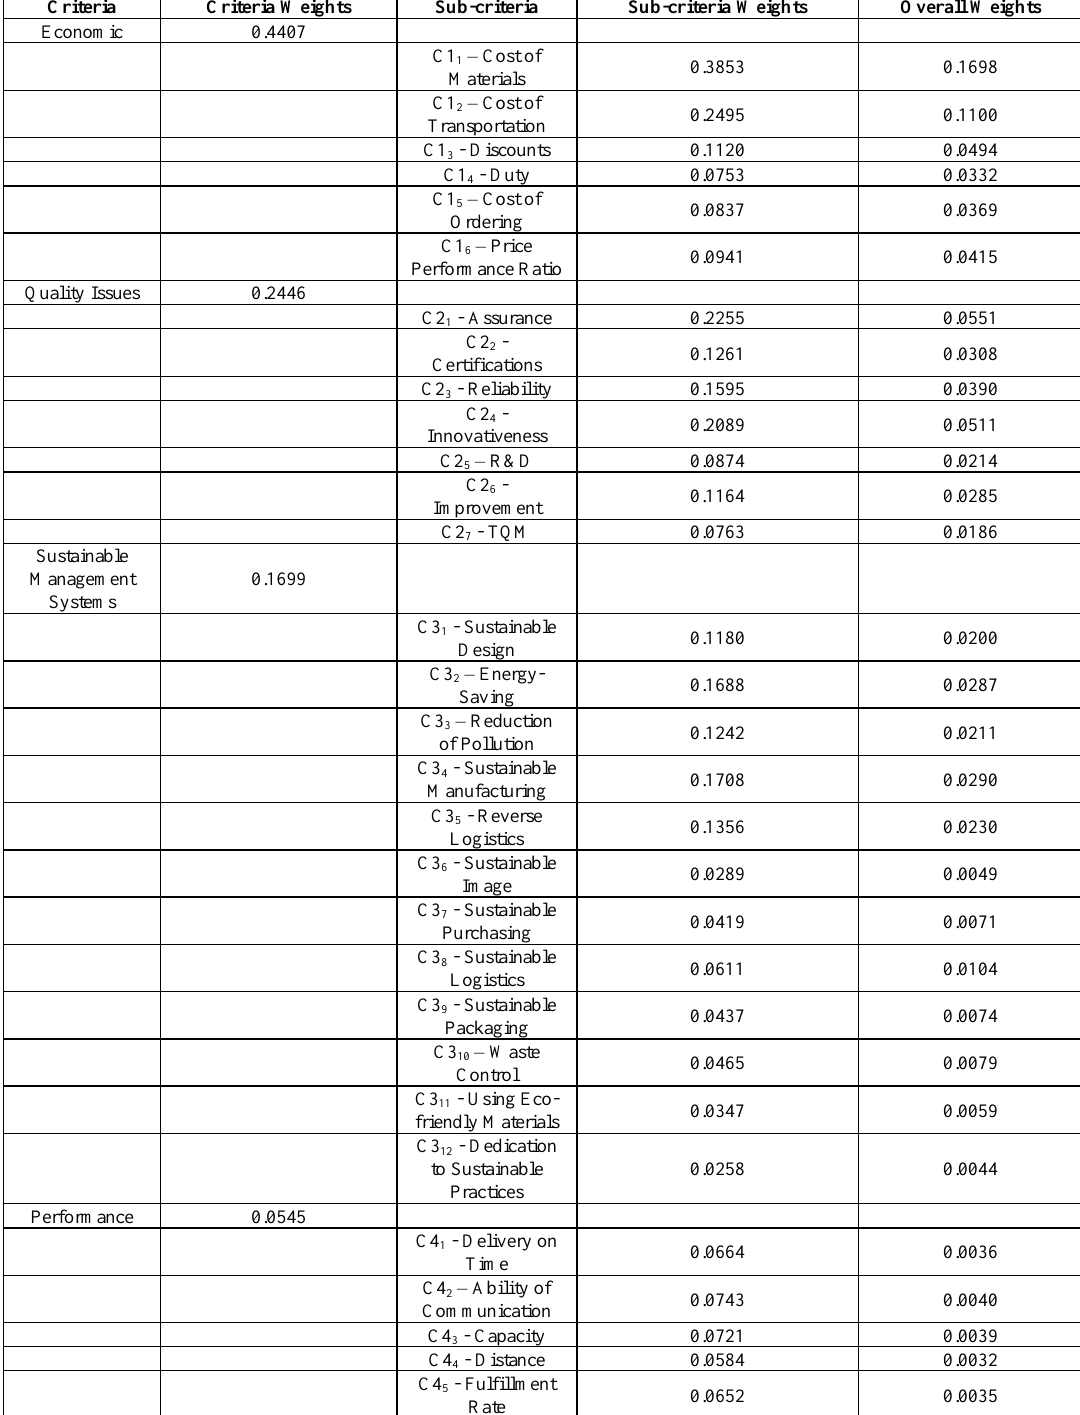
Table 9. Weights of